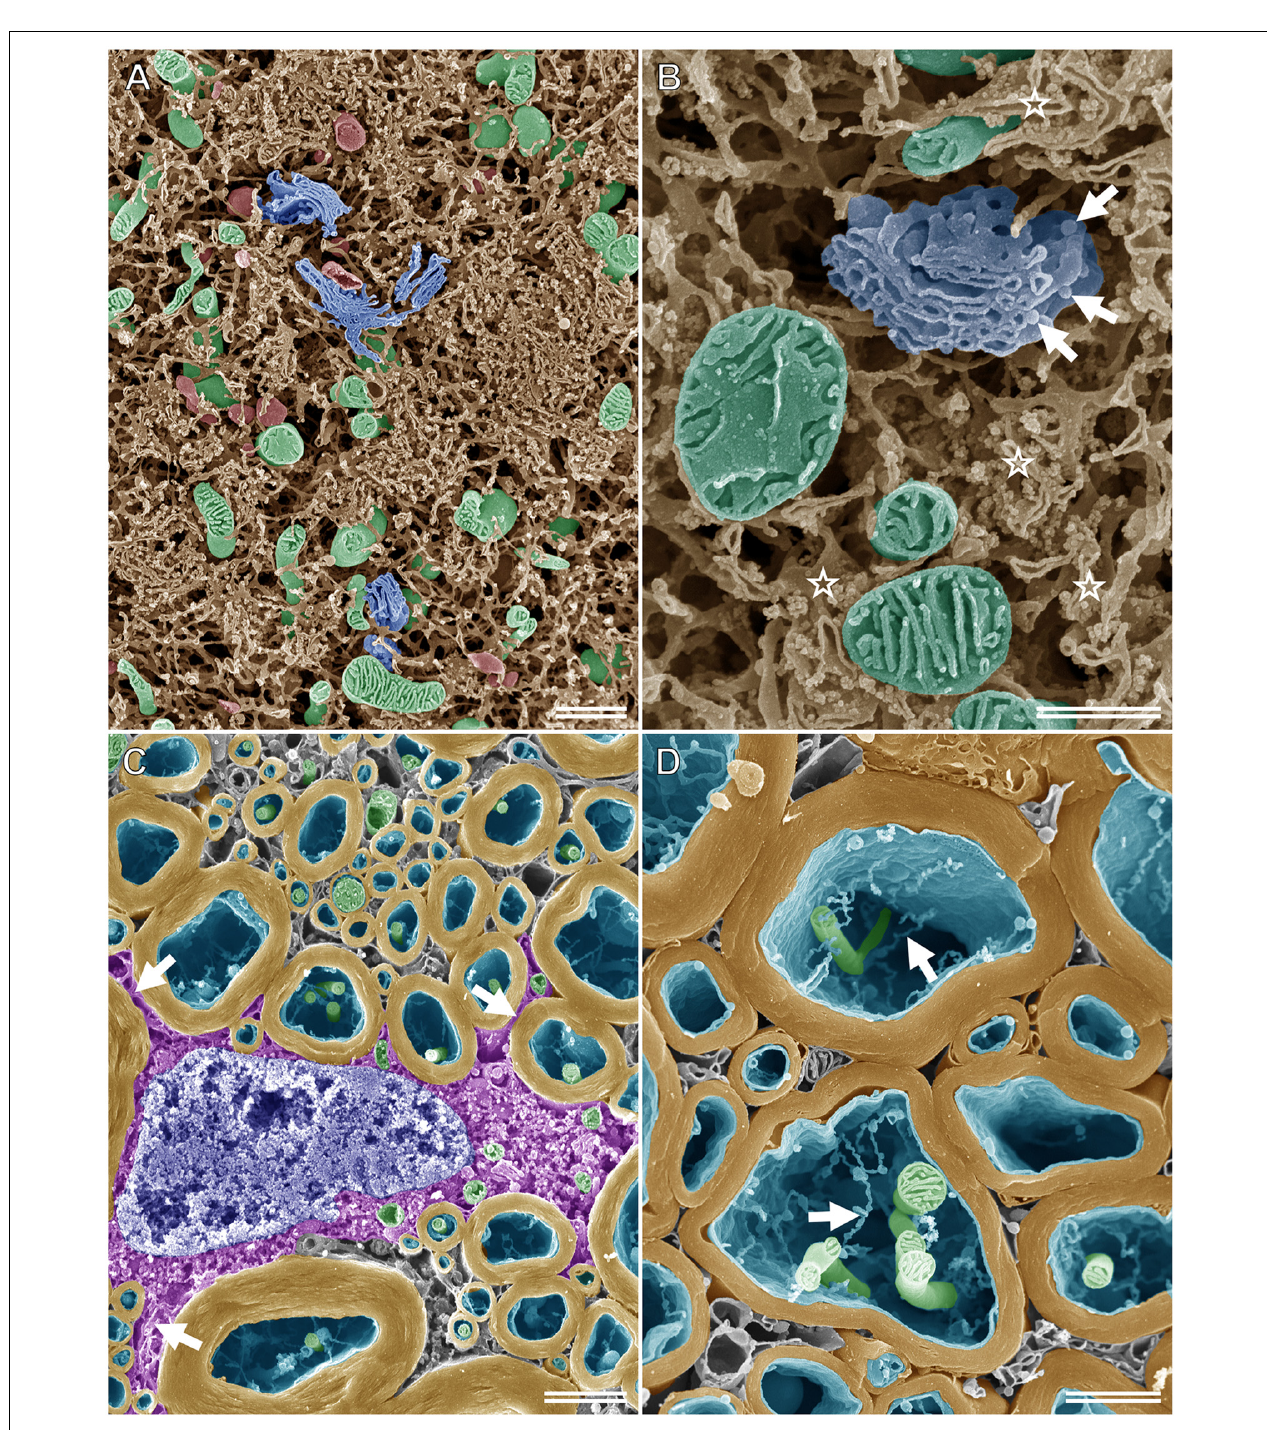
FIGURE 5 | SEM micrographs of nerve cells and tissues after performing the osmium maceration method. (A) Intracellular structure of the rat spinal ganglion cell showing part of the soma. The three-dimensional structure of the Golgi apparatus (blue), mitochondria (green), lysosomes (red), and endoplasmic reticulum (ER; brown) in the soma of the rat spinal ganglion cell observed using SE-mode SEM. (B) High magnification image of the Golgi apparatus (blue), mitochondria (green), and ER (brown) in the soma of the rat ganglion cell. Ribosomes can be recognized on the cisterns of the flat ER sheets (stars). Arrows: vesicles attached on the periphery of the Golgi cisterns. (C) The myelin sheath (yellow), axons (cyan), and oligodendrocytes (magenta) in the white matter of the rat spinal cord on the freeze-cracked surface. Arrows: processes of the oligodendrocytes, which arise from the cell body. Green: mitochondria, blue: nucleus. (D) Closer view of the myelin sheath (yellow). Both mitochondria (green) and tubular-shaped membranes (arrows) in the axon (cyan) are clearly visible. (A) Scale bar: 1 µ m; (B) scale bar: 500 nm; (C) scale bar: 1.5 µ m; (D) scale bar: 1 µ m.